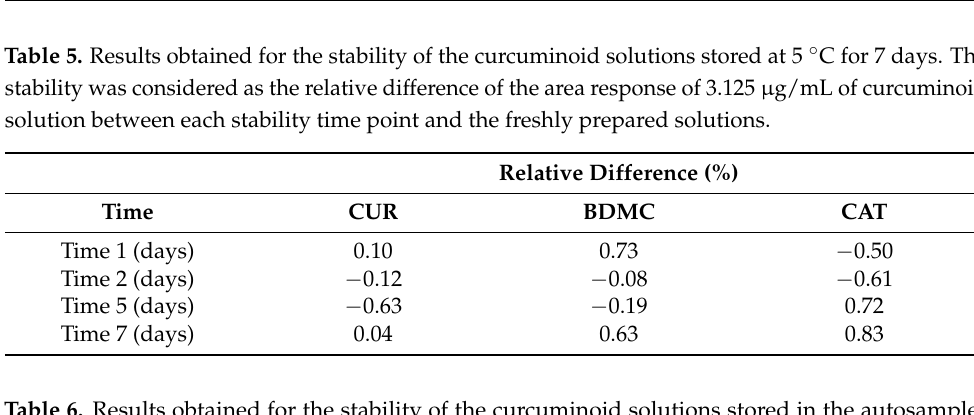
Table 6. Results obtained for the stability of the curcuminoid solutions stored in the autosampler (room temperature) for 24 h. The stability was considered as the relative difference of the area response of 3.125 µ g/mL of curcuminoid solution between the freshly prepared solutions and 24 h after storage in the